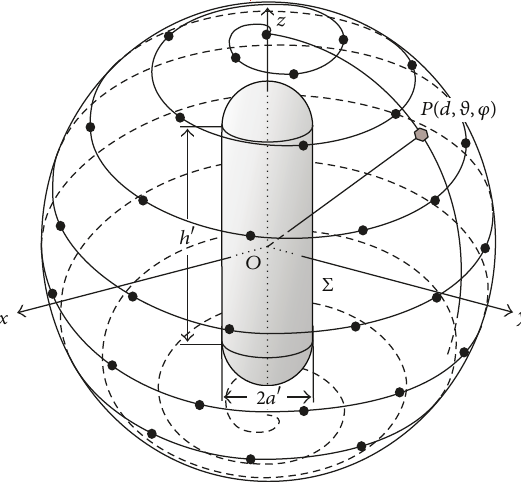
Figure 13: Spherical spiral scanning for an elongated